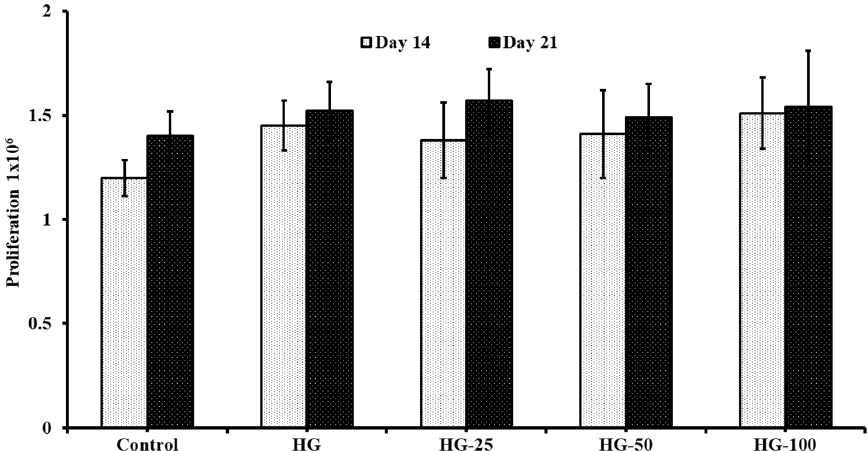
Figure 5. The cell growth of osteogenic cells differentiated from MSCs. Control—cells without hydrogels, HG—hydrogels without VEGF, HG-25, -50, and -100—hydrogels with 25 ng/mL, 50 ng/mL, and 100 ng/mL of VEGF, respectively.